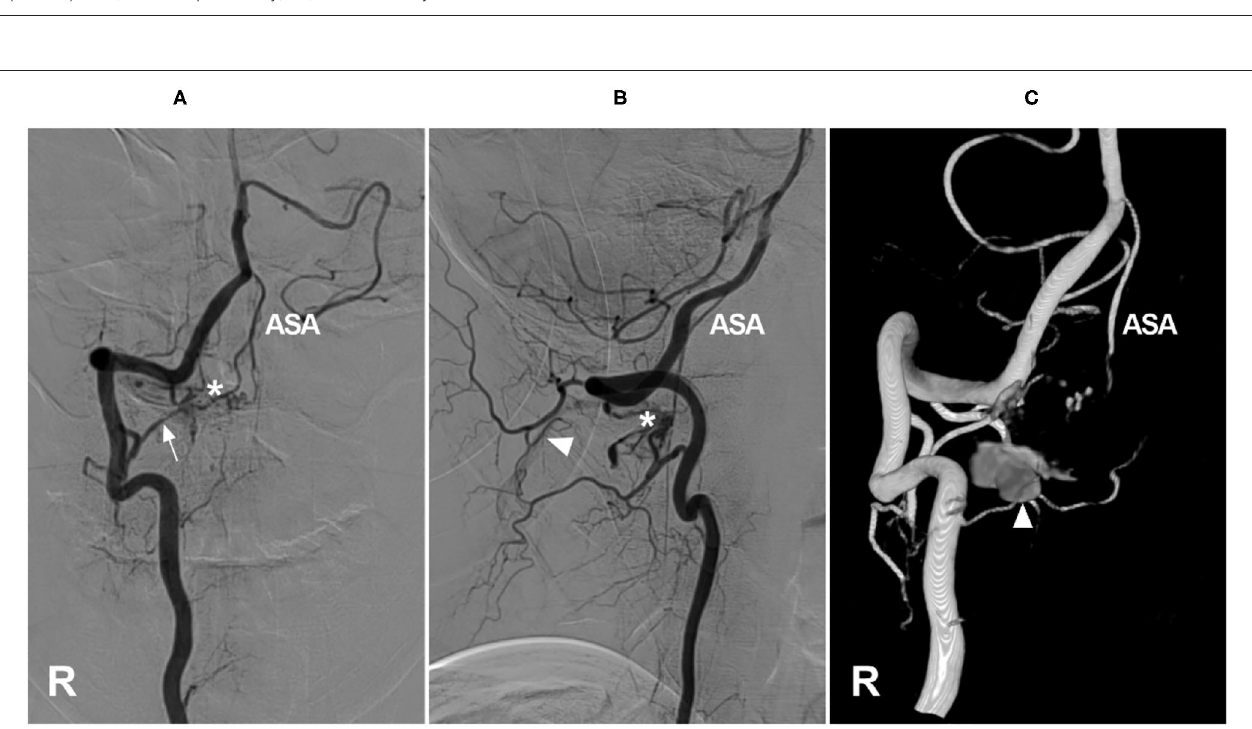
FIGURE 2 | Cervical epidural arteriovenous fistula. (A–C) Right VA anteroposterior view (A) , lateral view (B) , and three-dimensional (C) angiograms showed an epidural arteriovenous fistula (asterisk), the arrow shows the feeding artery and the ASA were involved, with draining to the suboccipital venous plexus (triangle). ASA, anterior spinal artery; R, right; VA, vertebral artery.